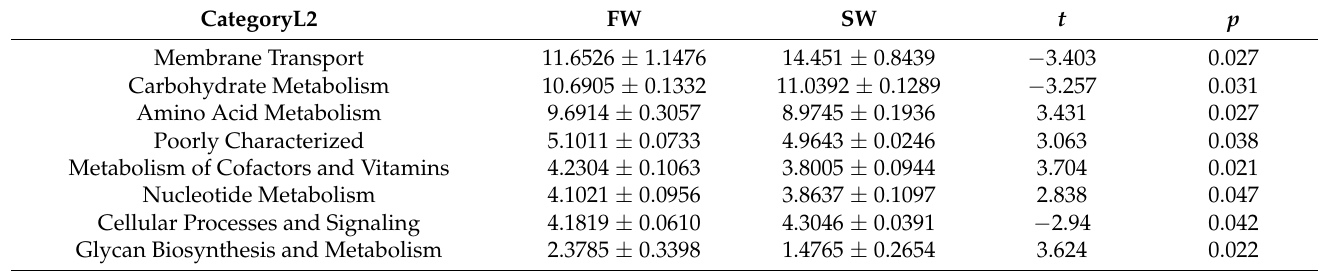
Figure 3. BugBase showing predicted relative abundance of Potentially_Pathogenic in FW leeches and SW leeches. Table 3. PICRUSt showing predicted relative abundance of KEGG ortholog groups (Level 2